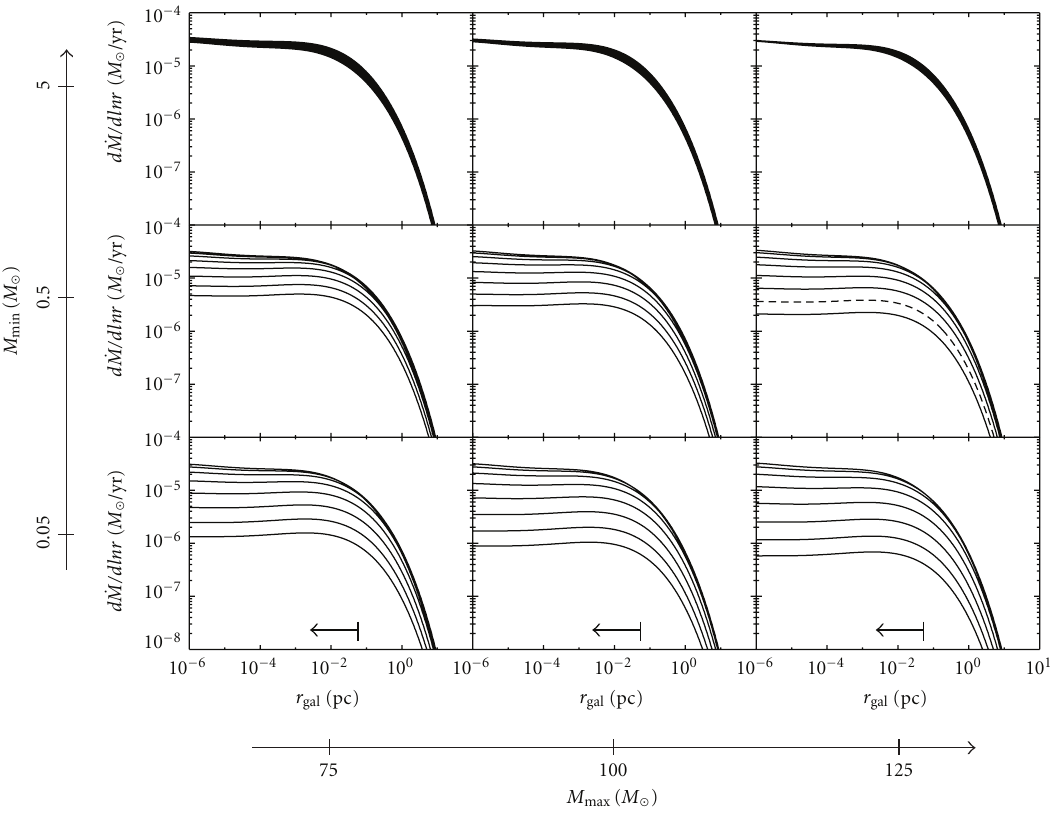
Figure 9: Mass loss rates as a function of Galactic radius due to direct collisions for various parameters of M min , M max , and α . The parameter M min varies in each panel from bottom to top, and M max varies from left to right. The power law slope, α , varies within each panel from 1.00 (top line) to 2.5 (bottom line) in equal increments of 0.188. The dashed line corresponds to a Salpeter-like mass function values ( M min = 0 . 5 M (cid:5) , M max = 125 M (cid:5) , α = 2 . 29). The arrows indicate the range in the di ff use X-ray observations ( r gal < 1 . 5 (cid:3)(cid:3) ) which we use to constrain the PDMF (see Section